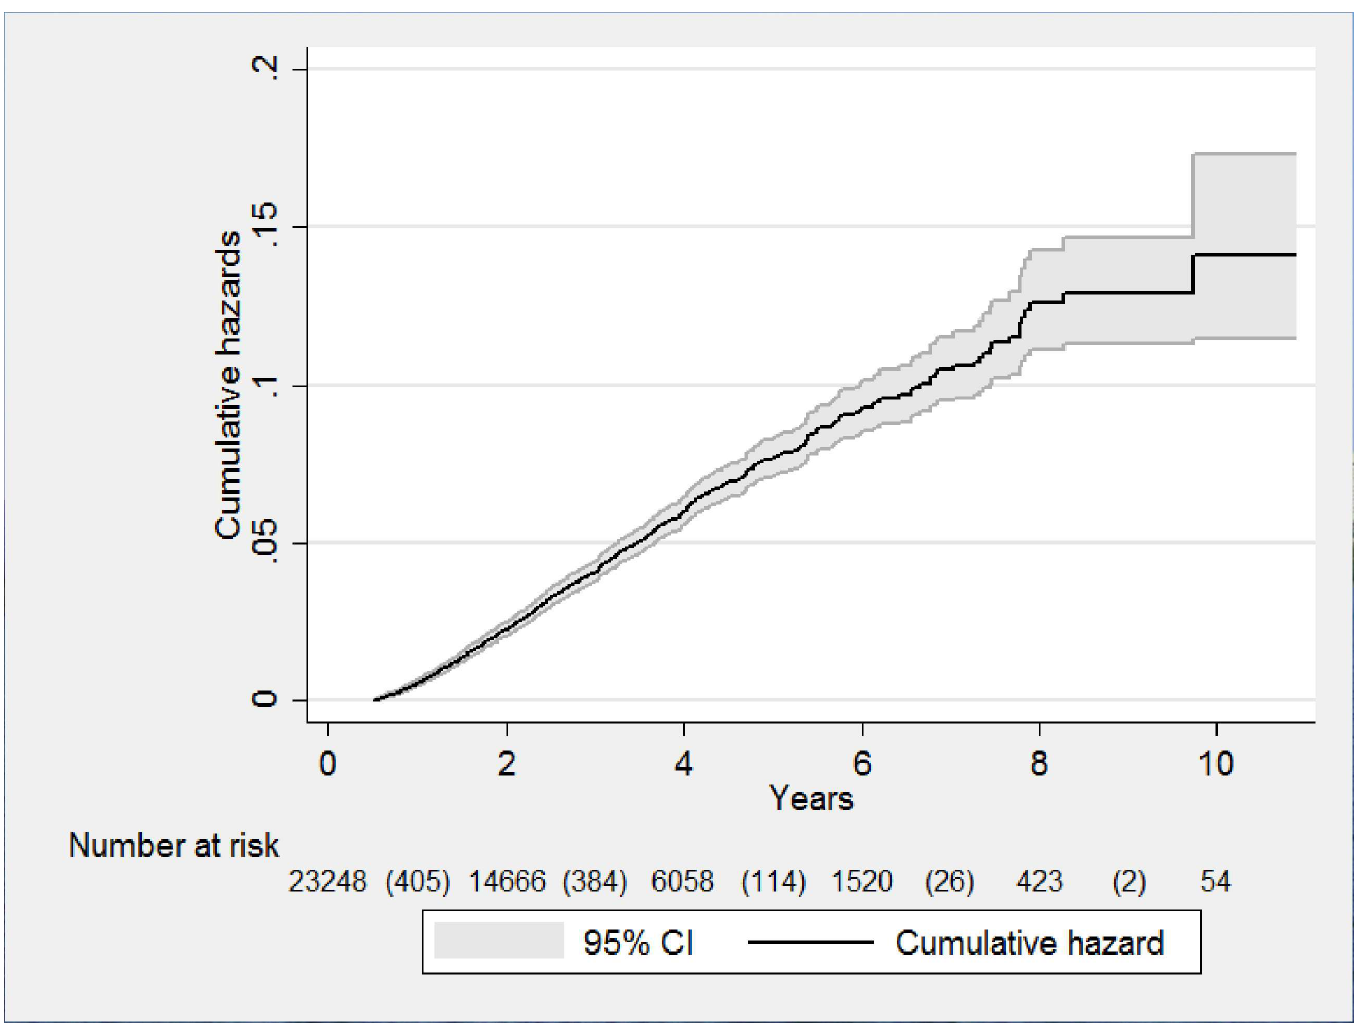
Fig 2. Nelson Aalen curve showing the cumulative hazard of switching to second-line ART after starting first-line ART at the Integrated HIV Care program, Myanmar, between 2005 and